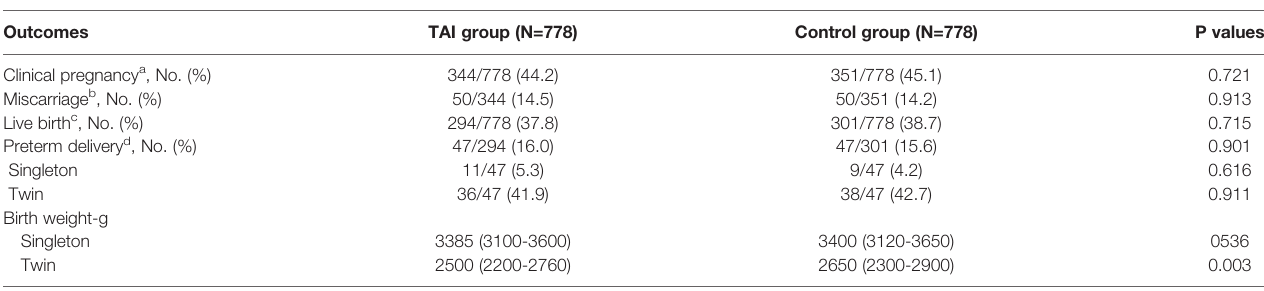
TABLE 4 | Pregnancy outcomes in the TAI and control groups.